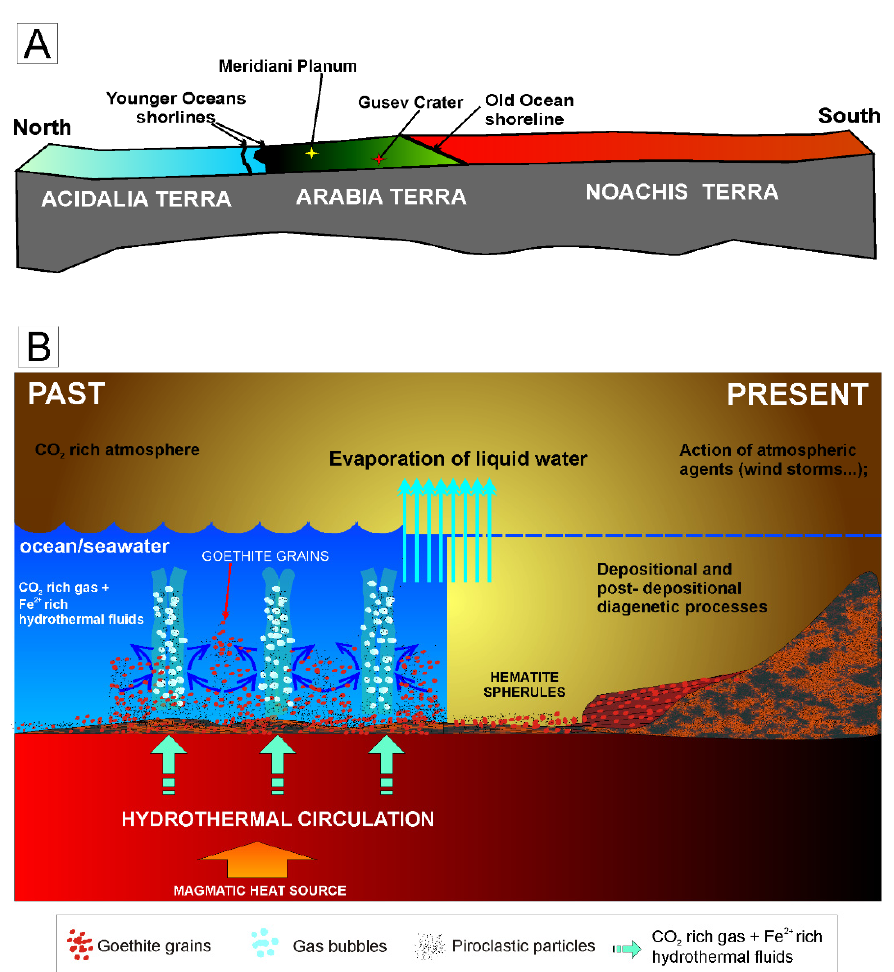
Figure 7. ( A ) Redrawn image from Mars Orbital Laser Altimeter (MOLA) by Dohm et al. [51], extending from the North Pole to the South Pole and including Terra Arabia Region where Meridiani Planum is located. The image displays the putative shorelines of more ancient and younger oceans between which Meridiani Planum and Gusev Crater are enclosed, suggesting that, in the past, they were areas flooded with water [48–51]. ( B ) Conceptual model displaying the Martian goethite spherules formation process in the past and present occurrence in soils and layered sedimentary rocks at Meridiani Planum. In the past, spherules formed in hydrothermal and acidic environment, like in Panarea area, where CO 2 and Fe-rich thermal fluids triggered goethite precipitation around particles deposited on the seafloor, acting as accretion nuclei. Then, dehydration processes contributed to transform the goethite spherules into haematite spherules, which presently occur at Meridiani Planum in sedimentary deposits and within layered